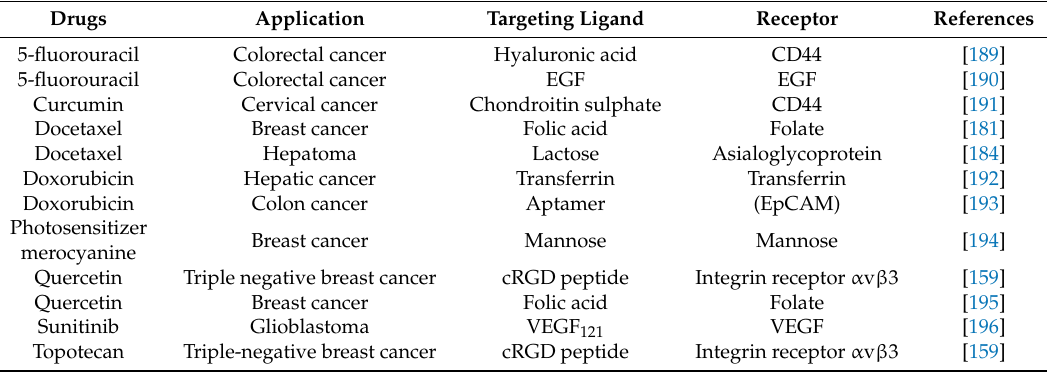
Table 7. List of some functionalized MSNs explored for tumour